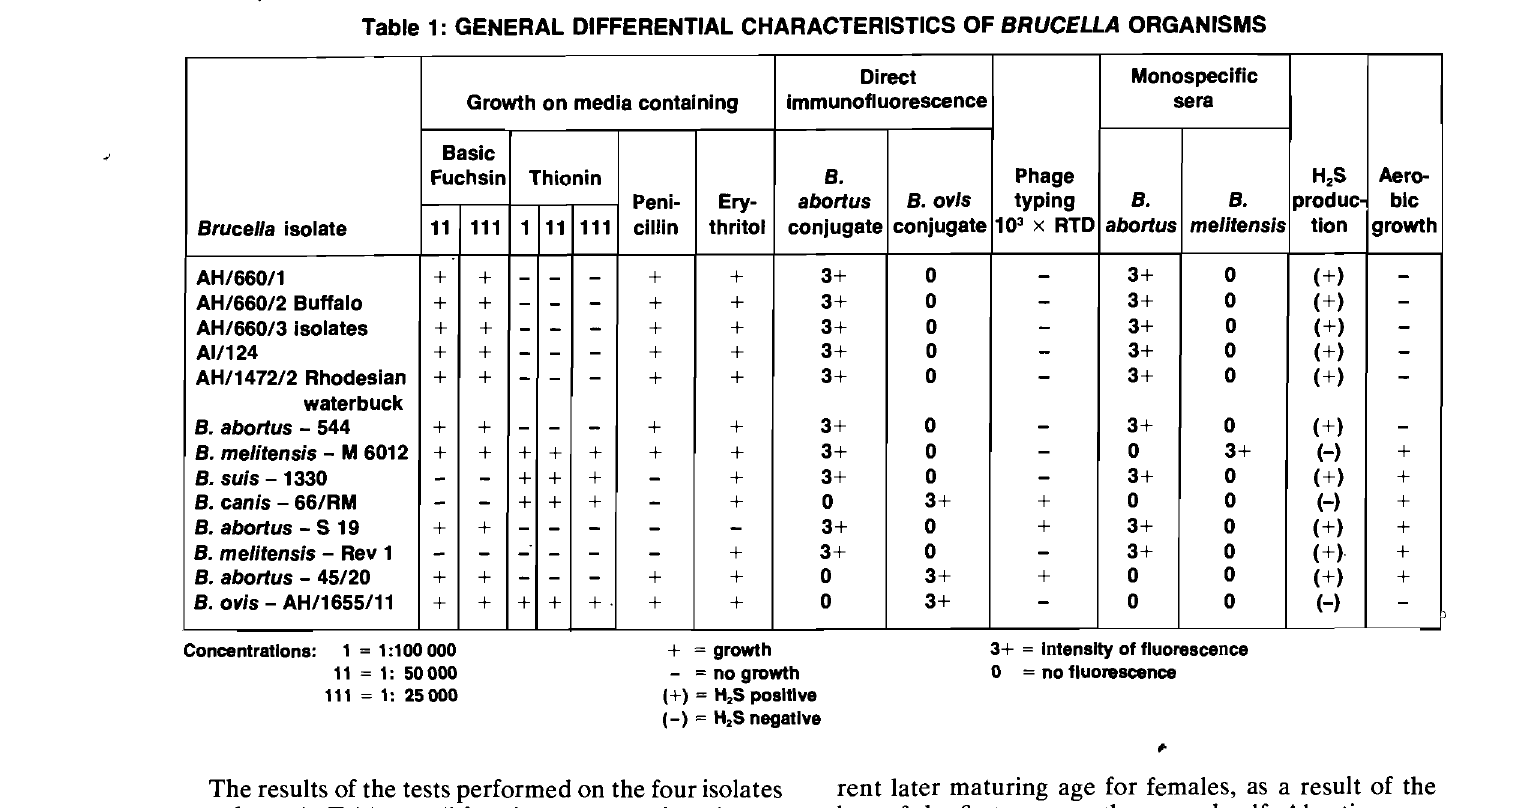
Table 1: GENERAL DIFFERENTIAL CHARACTERISTICS OF BRUCELLA